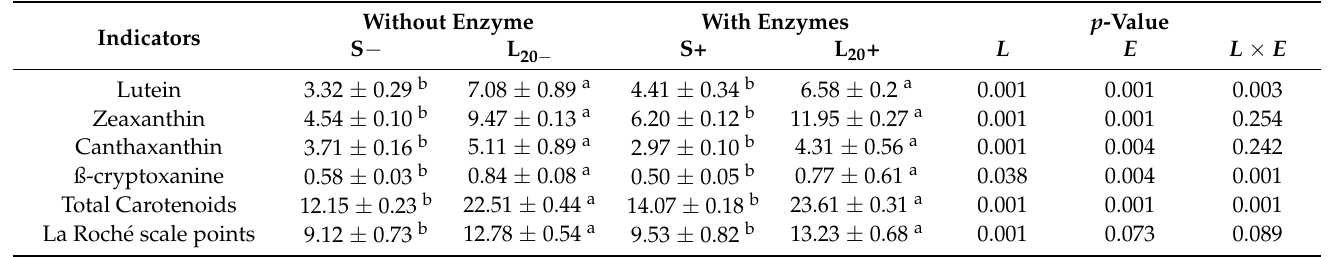
Table 9. Influence of enzymes addition in lupine-based diets on the carotenoids content ( µ g/g yolk) and the color of the yolk.